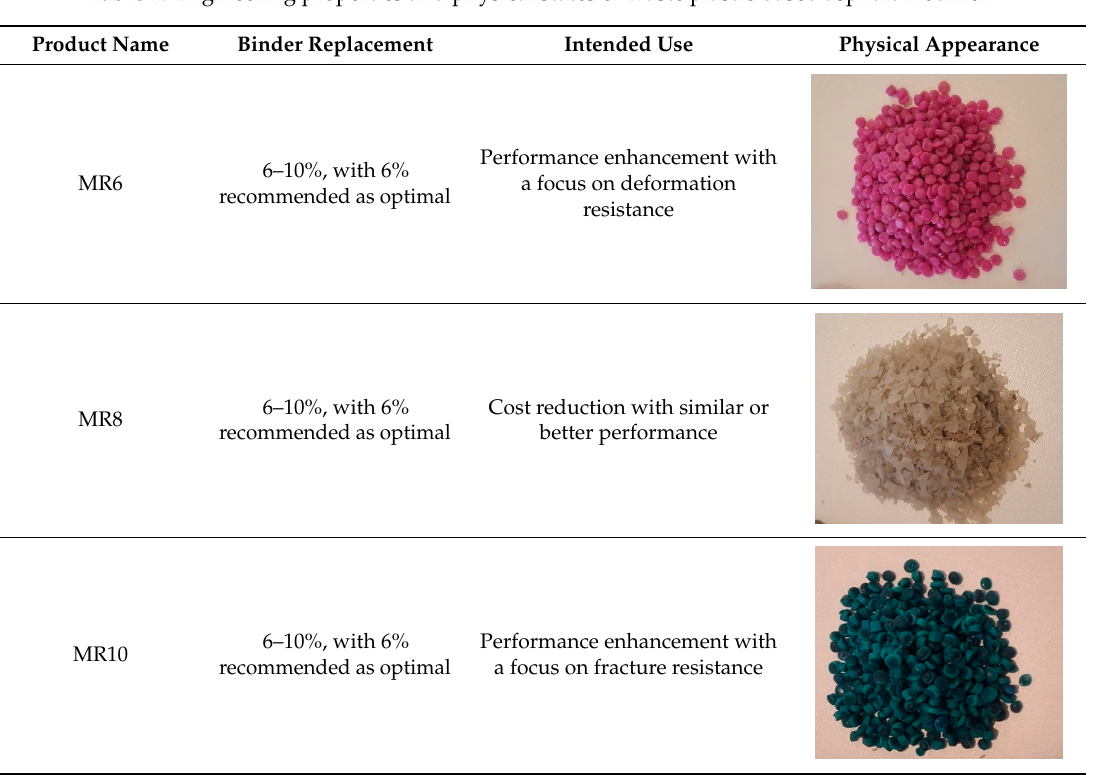
Table 1. Engineering properties and physical states of waste plastic-based asphalt modifier.